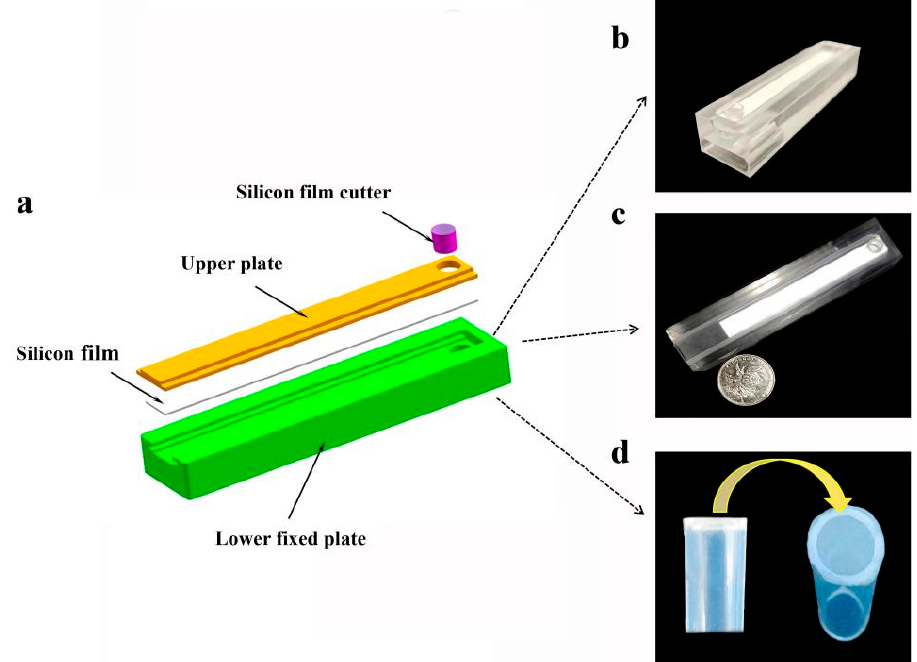
Figure 1. Structure and appearance of SMART: ( a ) the exploded view of SMART; ( b ) side view of SMART; the round hole is for installing the temperature sensor, and the square groove is for the heating plate; ( c ) the image of SMART (the coin’s diameter is 25 mm); ( d ) the image of the silicon film cutter.